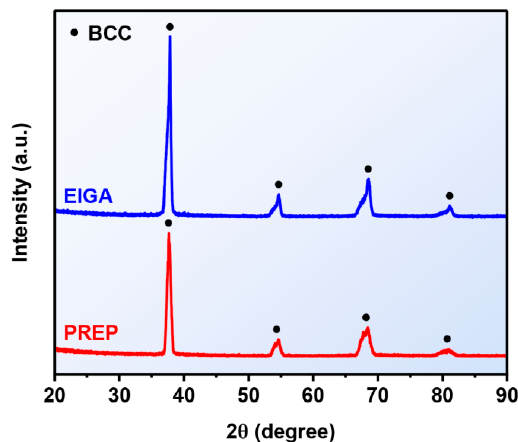
Figure 6. XRD patterns of the EIGAed and PREPed TaNbTiZr RHEA powders.